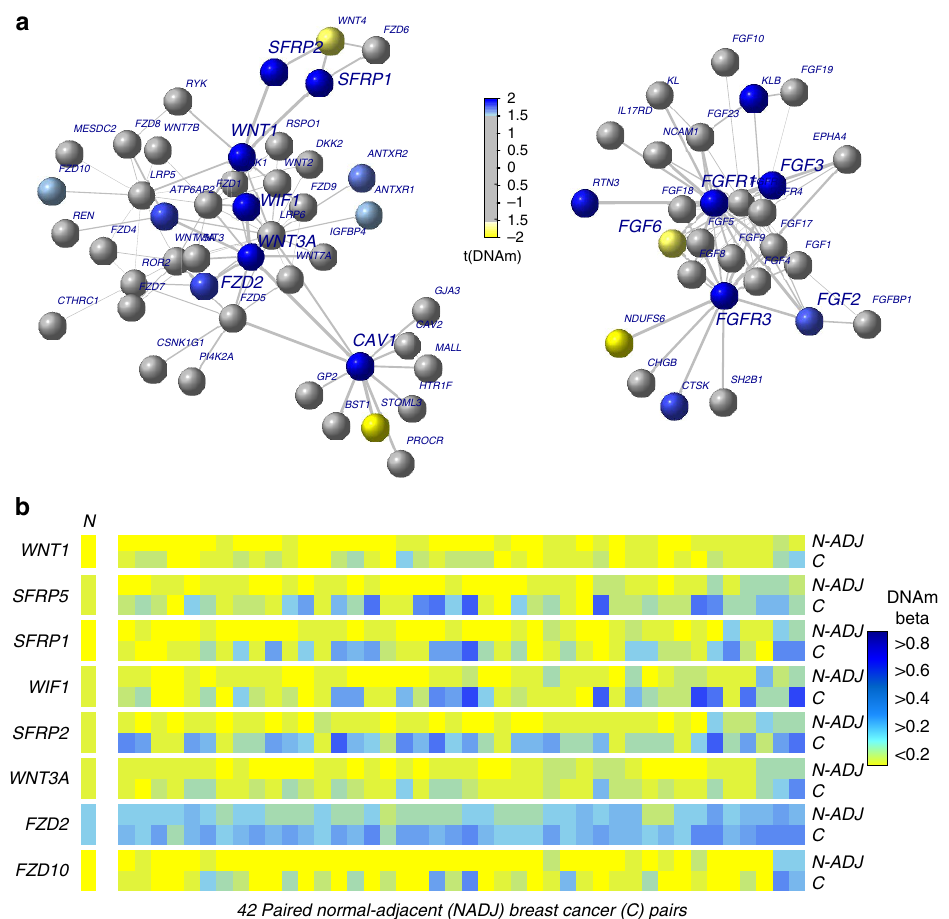
Figure 5 | Field defects are enriched for WNT and FGF signalling pathways. ( a ) Examples of two interactome hotspots of epigenetic deregulation comparing normal-adjacent to normal-healthy samples, inferred using the EpiMod/FEM algorithm. In colour, we indicate the nodes exhibiting significant DNA methylation changes. ( b ) Heat maps of DNA methylation of WNT-signalling pathway members for the 42 matched normal-adjacent (N-ADJ) breast cancer (BC) pairs. In the case of the normal samples from healthy subjects (N), we show the average DNA methylation values across all 50